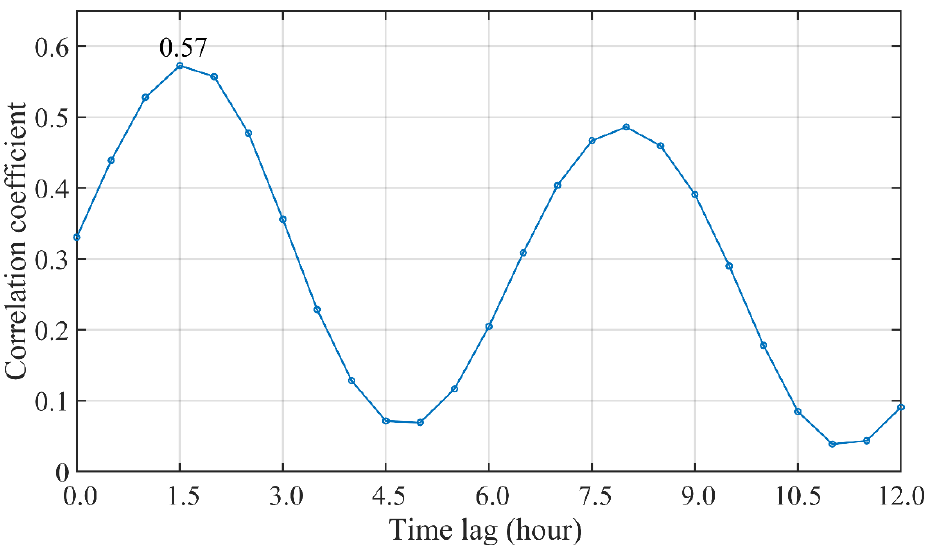
Figure 10. Correlation coefficients between the overall level of underwater noise (no low-pass filtering) and sea level calculated with various time lags at 0.5-h intervals.